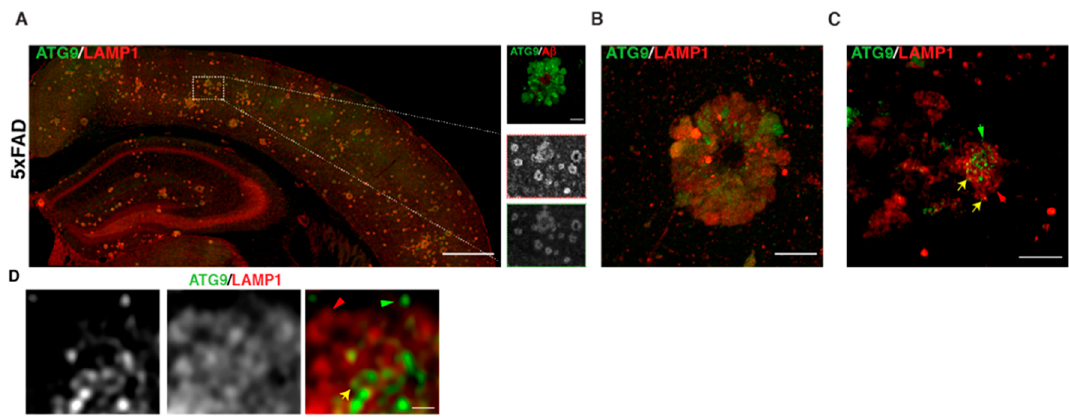
Figure 5. Autophagic and lysosomal organelles building up in swollen axons in AD mouse brain includes ATG9- positive vesicles A–D. ATG9 and LAMP1 staining. ( A ) Stitched image of 5 × FAD mouse cerebral cortex showing accumulation of ATG9 and LAMP1 in axonal swellings around plaques. Region within white box is zoomed in the inset. ( B ) Standard confocal image of one amyloid plaque in 5 × FAD, which hints at varying levels of ATG9 vesicles in different dystrophies. ( C ) Airyscan image of a selection of dystrophies at one plaque shows that distinct vesicles that are positive for only LAMP1 (red arrow) or ATG9 (green arrow) or double positive (yellow arrow) are discernable. ( D ) Zoomed in look at a portion of one axonal swelling (airyscan mode) showing distinct vesicles for the first time. Scale bars—200 μ ( A ), 10 μ ( B ), 5 μ ( C ), and 1 μ ( D ).